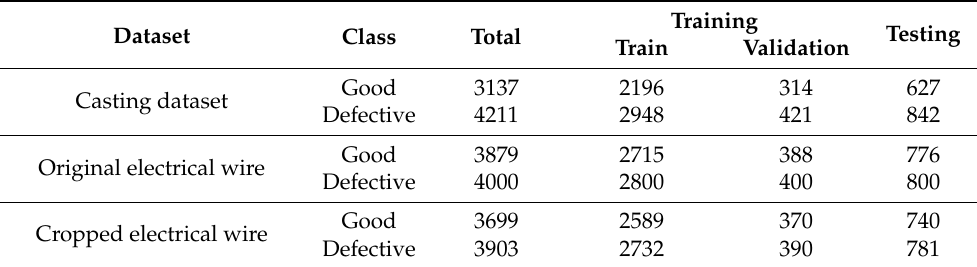
Table 2. Dataset distributions for training, validation, and